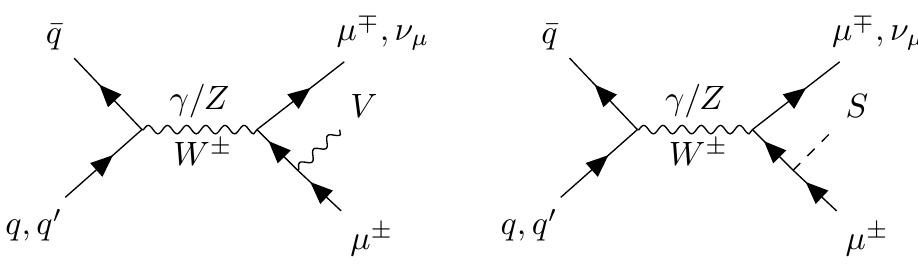
Figure 6 . Singlet production at a hadron collider via the neutral ( W -mediated) and charged ( γ/Z -mediated) Drell-Yan